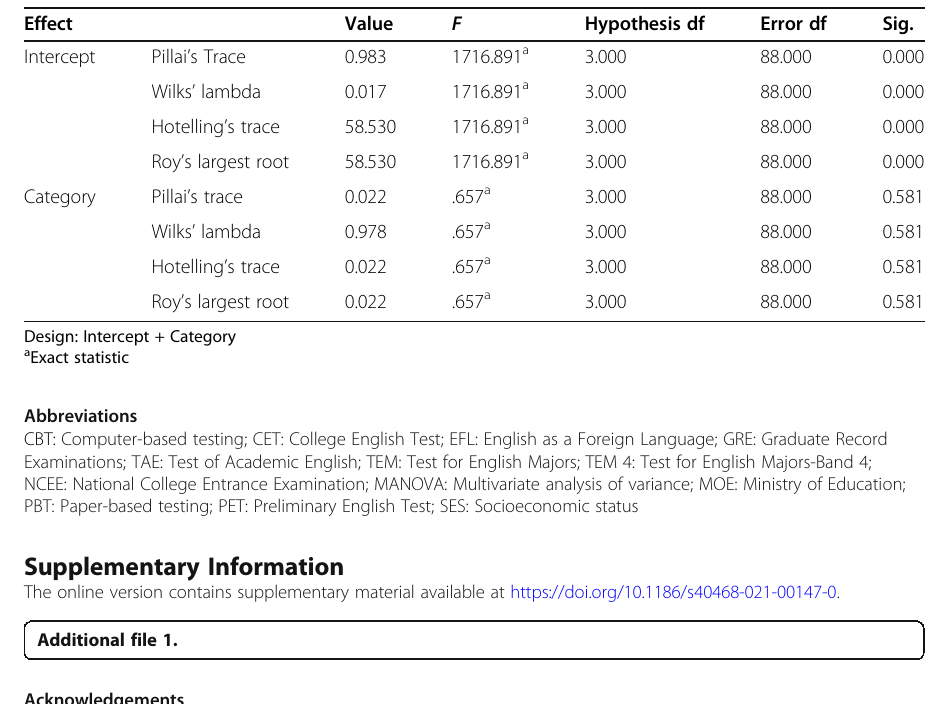
Table 10 Multivariate